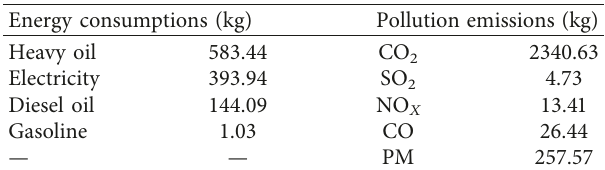
Table 5: The energy consumptions and pollution emissions of 1000m 2